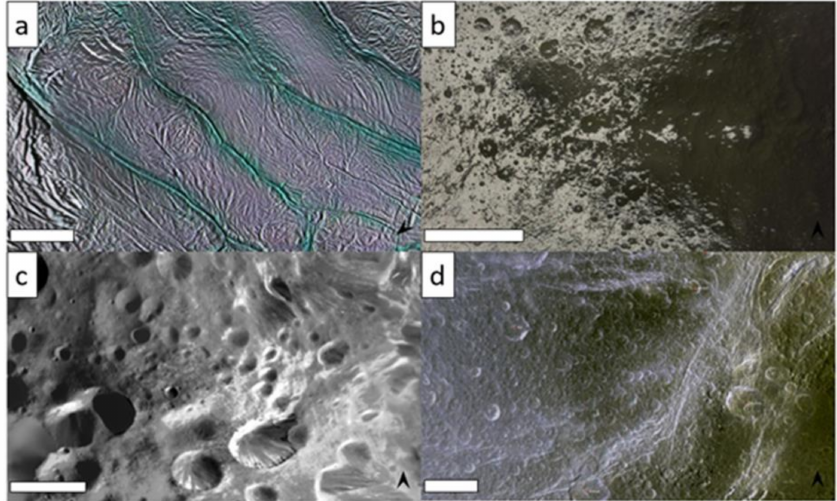
Figure 8. Examples of CO 2 -specific regions on Saturnian satellites as imaged by Cassini. ( a ) Tiger stripe southern pole on Enceladus (scale bar 25 km); ( b ) the darker leading hemisphere of Iapetus transitioning to the lighter albedo trailing hemisphere (scale bar 250 km); ( c ) cratered surface of Phoebe (scale bar 25 km); ( d ) Darker terrain on Dione (scale bar 100